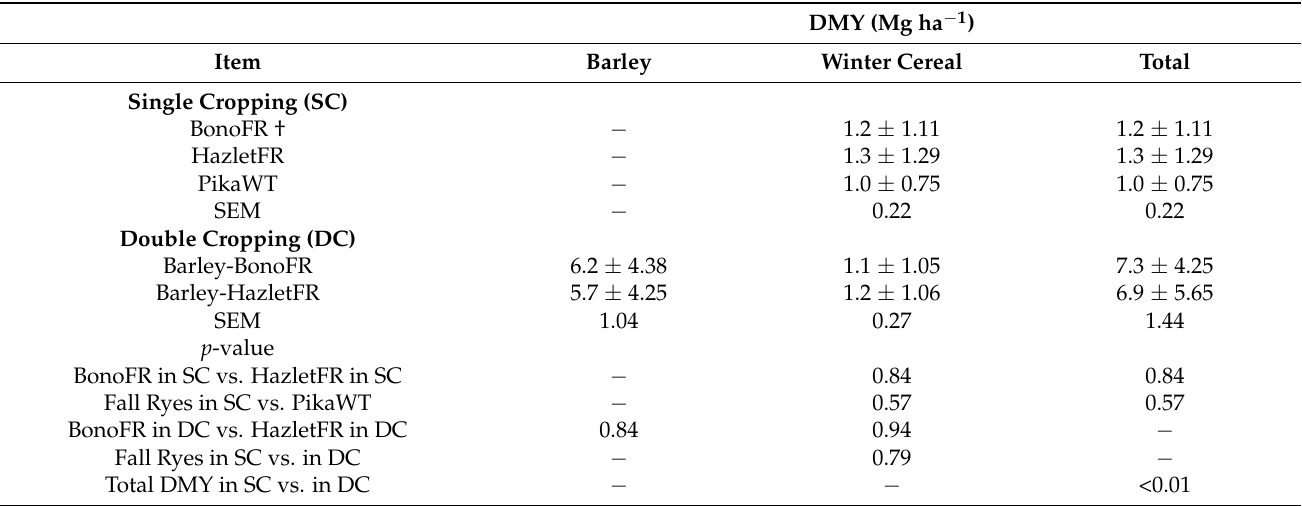
Table 3. Dry matter yield (means ± SD) of whole-crop winter cereals in single and double cropping